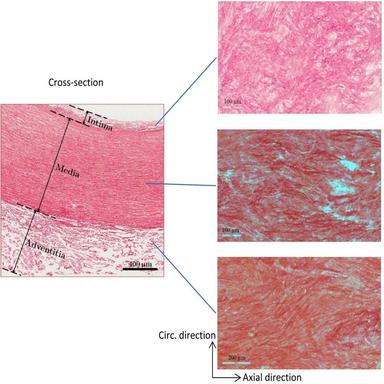
Picrosirius red-stained cross-section of the descending thoracic aorta from donor V with identification of the thicknesses of the tunica intima, media and adventitia. In-plane sections of the three layers after separation are also shown. In-plane sections are 10 μm thick, cross-section is 4 μm thick.